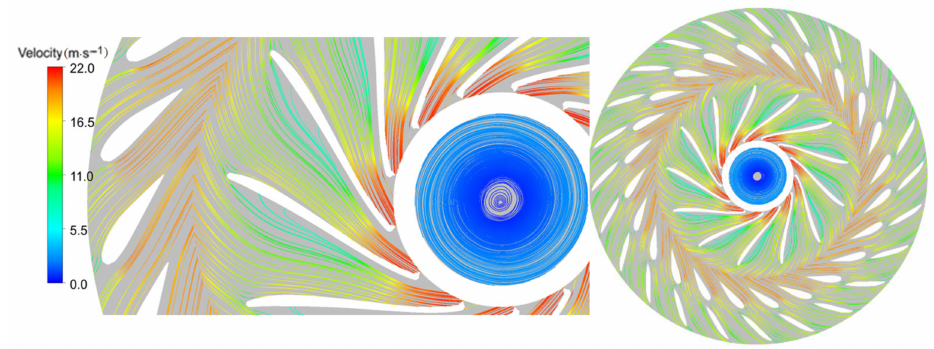
Figure 10. Flow pattern of vaneless space zone at 30 ◦ of opening.